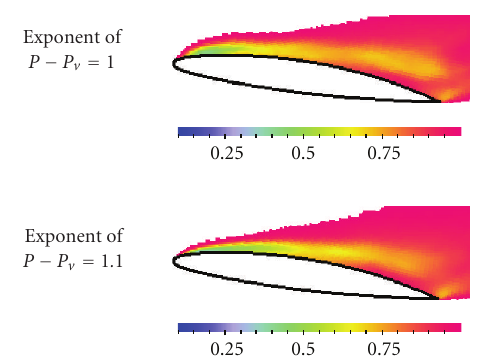
Figure 15: Influence of the exponent of P − P v on the behavior of the time-averaged cavity, L/c = 0 .